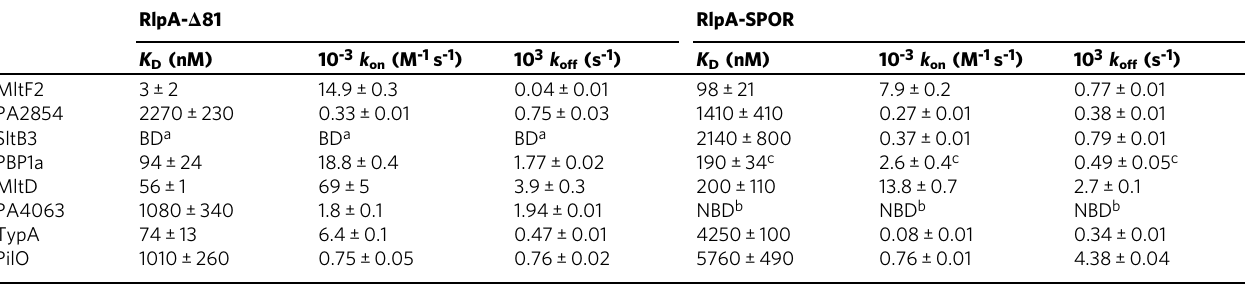
Table 3 The kinetics for binary interactions with the RlpA- Δ 81 and RlpA-SPOR constructs, as measured by SPR.